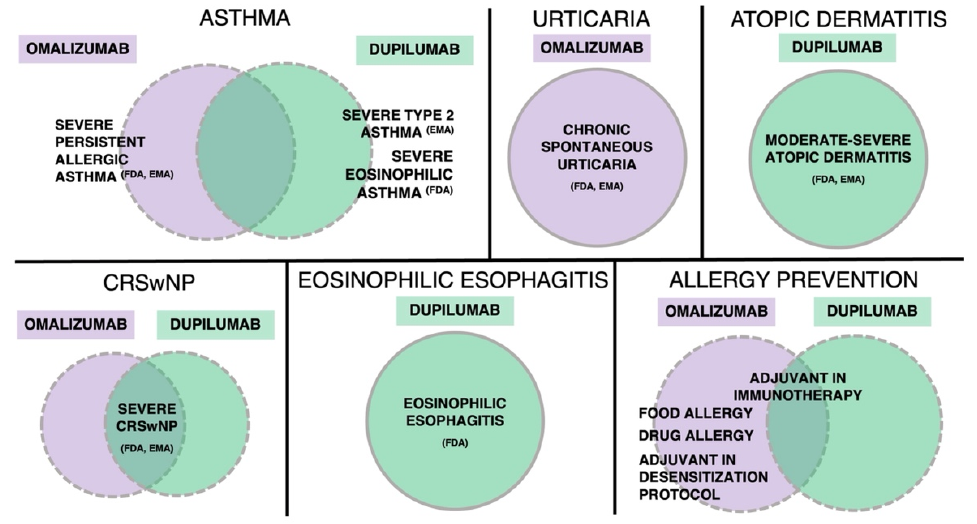
Figure 1. On-label indications and off-label promising uses of omalizumab and dupilumab in allergic inflammation (as of October 2022). Omalizumab is approved as an add-on treatment in severe persistent allergic asthma (FDA, EMA), similarly to dupilumab in severe type 2 asthma (EMA) and asthma with eosinophilic phenotype (FDA) or oral corticosteroid-dependent asthma, regardless of phenotype (FDA). Regarding allergic skin diseases, omalizumab is approved for the treatment of chronic spontaneous urticaria (FDA, EMA), similarly to dupilumab for the treatment of moderate- severe atopic dermatitis (FDA, EMA). Both biologics have been approved in patients with severe chronic rhinosinusitis with nasal polyps (FDA, EMA). In eosinophilic esophagitis, dupilumab has recently been approved by the FDA. Considering prevention of allergic reactions, both biologics are under investigation as adjuvant in oral immunotherapy. Omalizumab is used off-label as adjuvant in desensitization protocols to prevent breakthrough reactions. FDA denotes U.S. Food and Drug Administration, EMA European Medicines